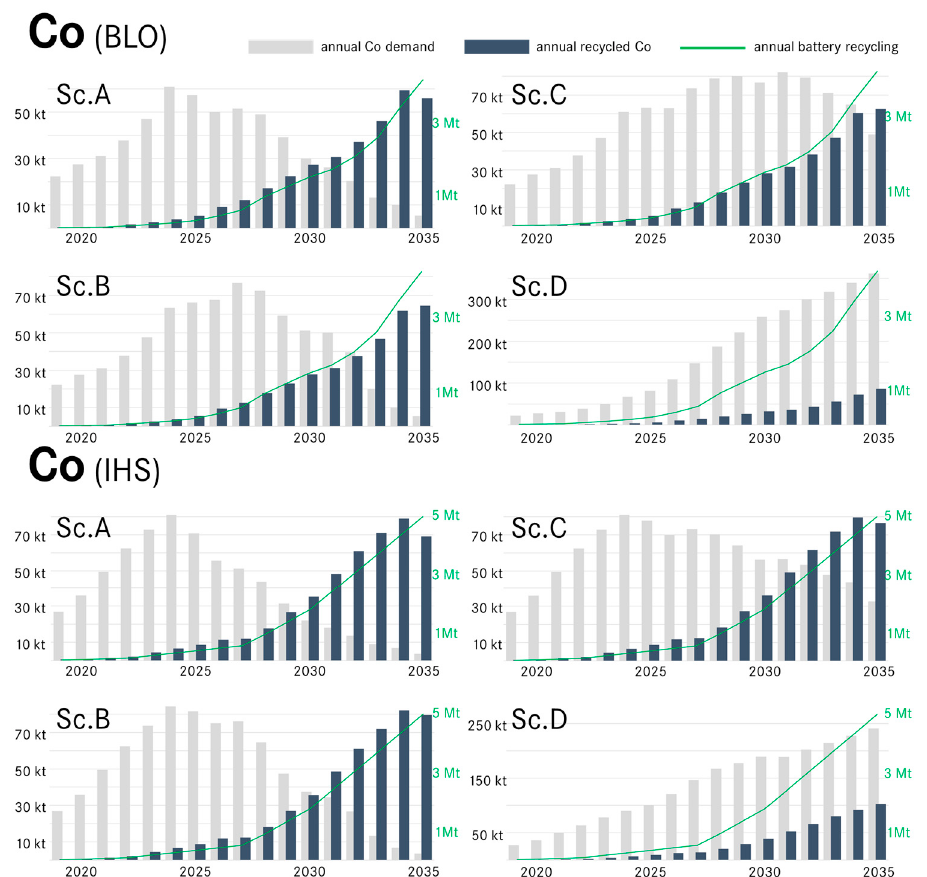
Figure 4. Comparison of scenarios (Sc) regarding cobalt (Co) trend with Bloomberg (BLO) and IHS forecast .